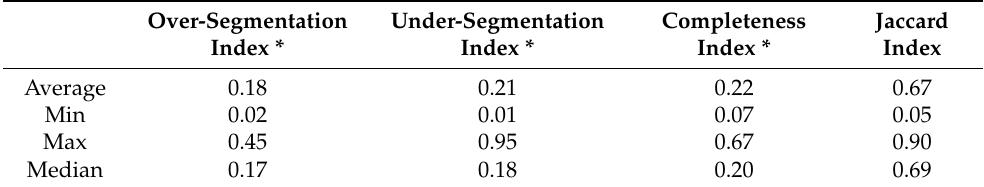
Table 9. Results of the quantitative assessment indices for the segmentation.